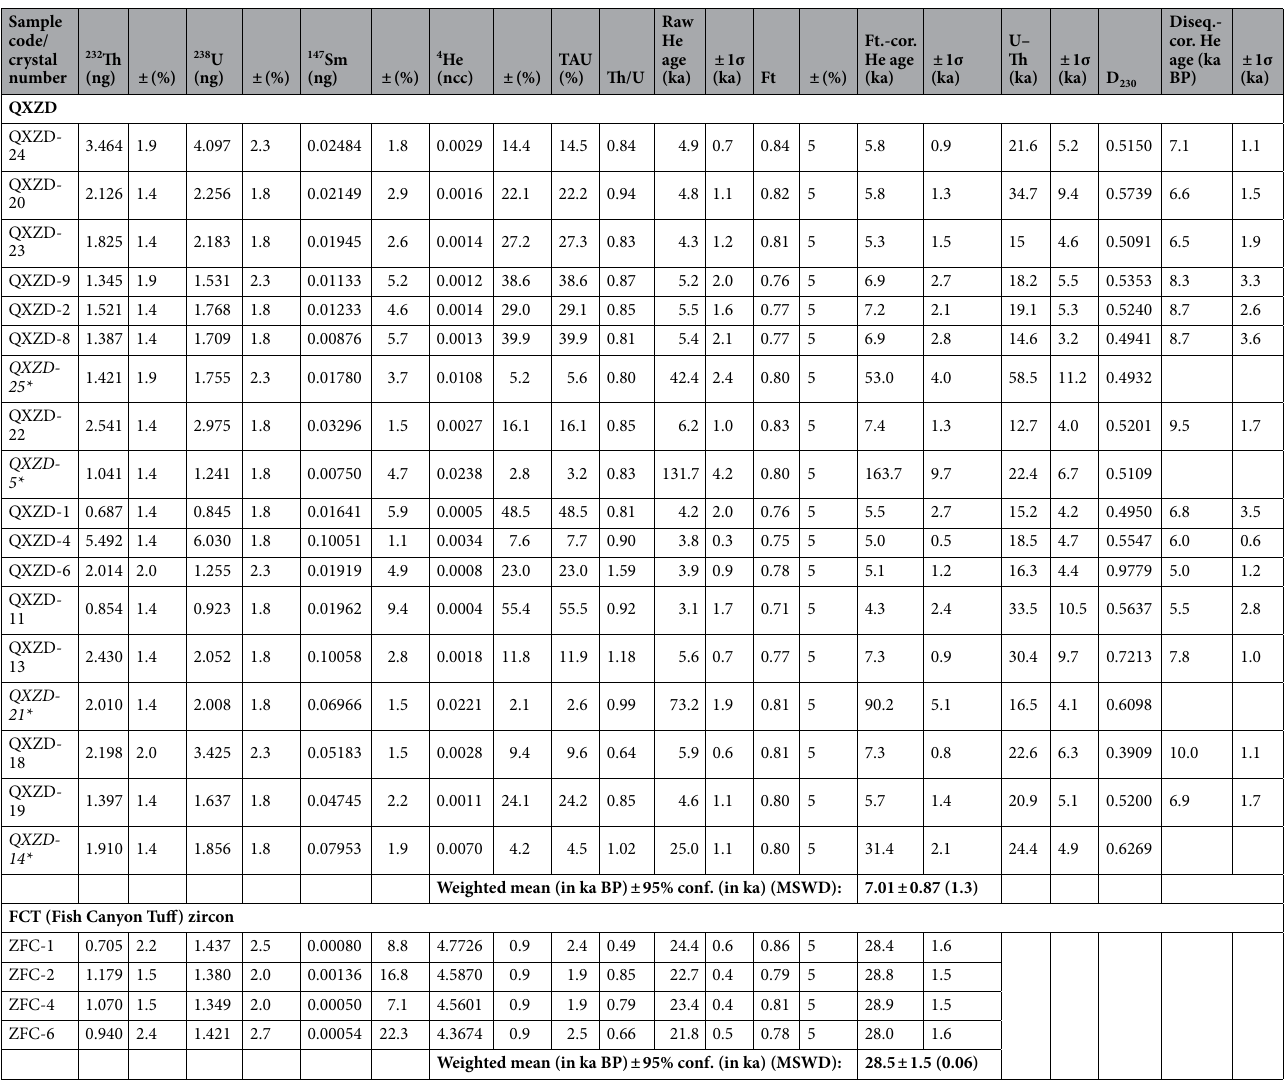
Table 2. Summary of the Zircon double dating data results for the Qixiangzhan eruption. TAU—total analytical uncertainty;